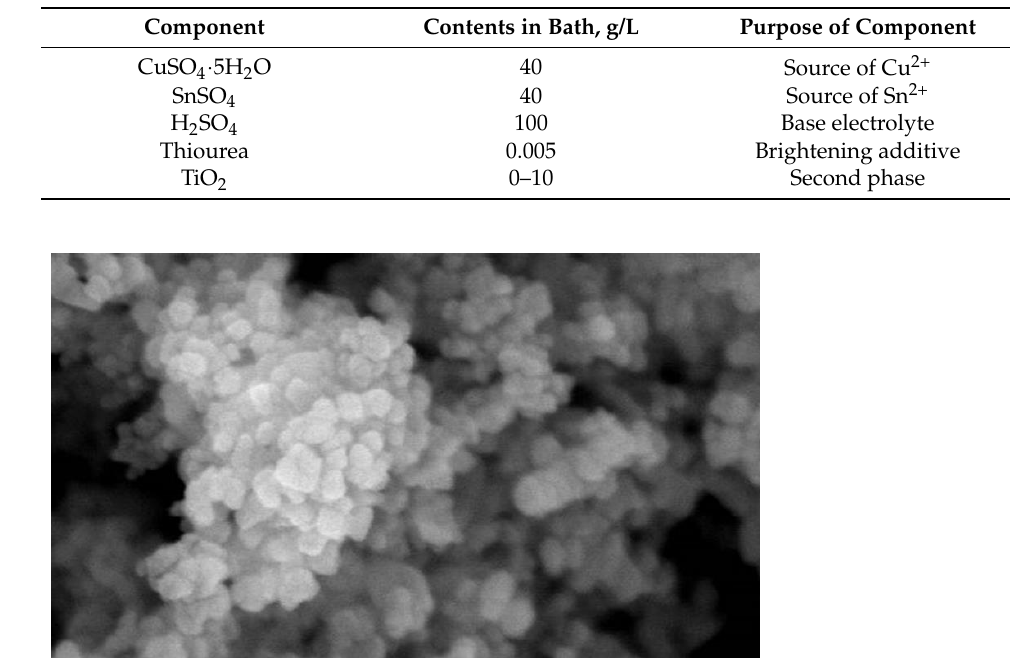
Table 1. Composition of the sulfate bath for electrodeposition of Cu–Sn–TiO 2 composite coatings.